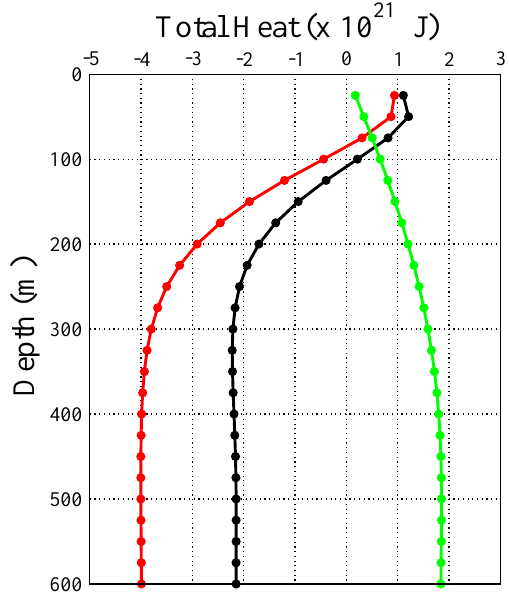
Fig.7. Meanheatcontentchangeovertheexperimentaldomainasafunctionofdepth. Pointsrepresentsthe Figure 7. Mean heat content change over the experimental domain heatcontentintegralfromthesurfacetoagivendepthwithrespecttogeothermalequilibrium. Contributions as a function of depth. Points represent the heat content integral fromtheGSTHand(LGC+GSTH)arerepresentedbytheredandblackcurves,respectively.Thegreencurve from the surface to a given depth with respect to geothermal equi- representstheirdifference,thatis,thecontributionofLGCtosubsurfaceheatcontent. librium. Contributions from the GSTH and (LGC + GSTH) are rep- resented by the red and black curves, respectively. The green curve represents their difference, that is, the contribution of LGC to sub- surface heat